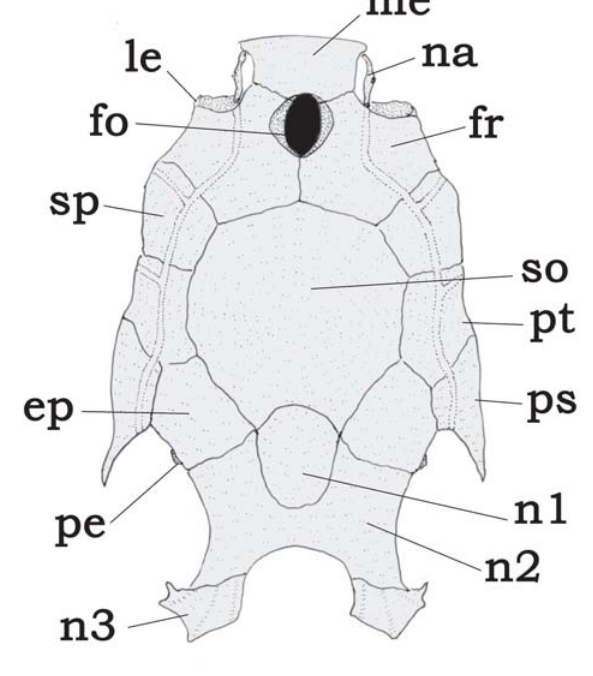
Fig. 3. Neurocranium of Tatia gyrina , INPA 20971, 28.0 mm SL. Dorsal view. Abbreviations: ep , epioccipital; fo , single cra- nial fontanel, fr , frontal; le , lateral ethmoid; me , mesethmoid; na , nasal; n1 , first nuchal plate, n2 ; second nuchal plate; n3 , third nuchal plate; pe , posterior epioccipital process; ps , posttemporal-supracleitrum; pt , pterotic; so , supraoccipital; sp , sphenotic. Scale bar = 1.0